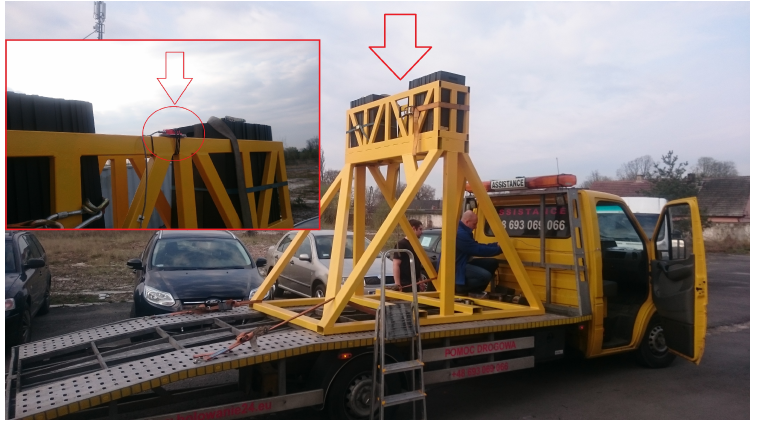
Figure 5. An application of the XSENS MTi-28A53G35 sensor for measurement tests [Source: MovieBird